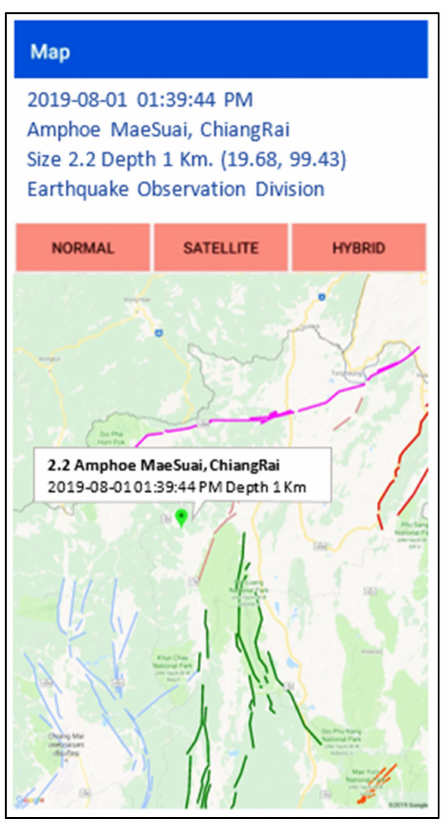
Figure 5. The original design of EarthquakeTMD’s earthquake report